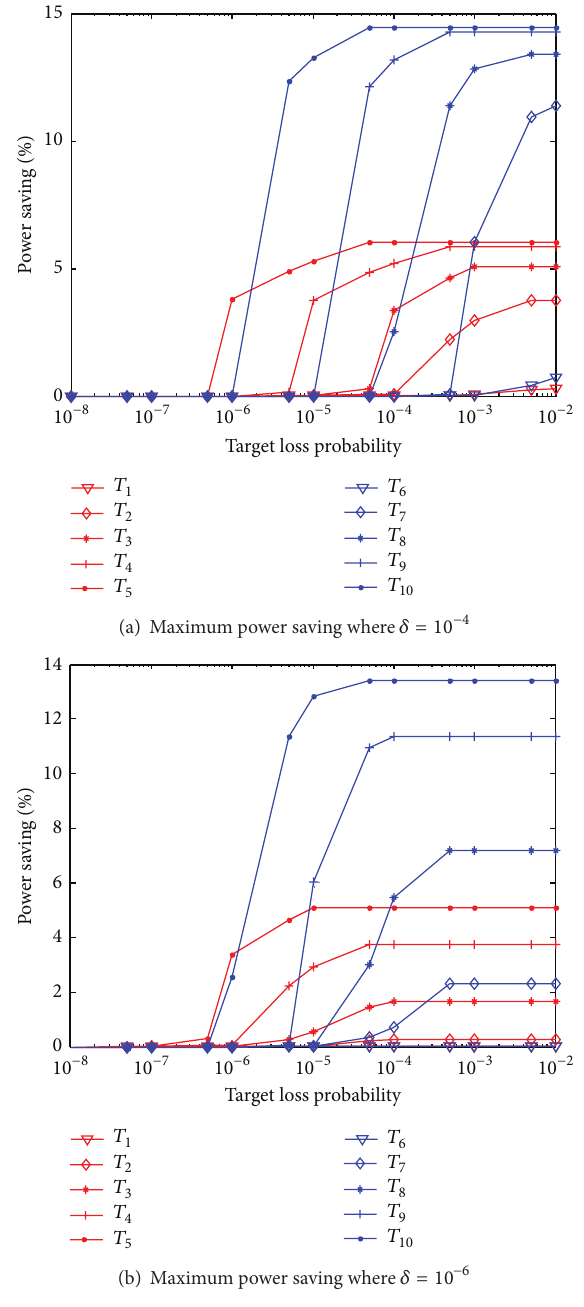
Figure 10: Power saving versus target loss probability resulted by optimization problem fixing 𝛿